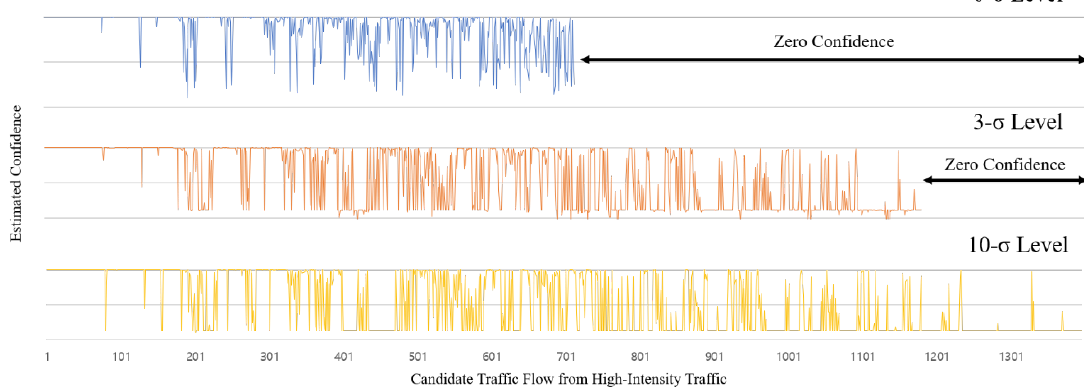
Figure 15. Confidence measurement trend according to padding setting. As the σ value increases, the estimation becomes more flexible. As shown in the actual graph, it can be seen that the number of completely excluded subjects whose confidence is measured to be 0 changes.